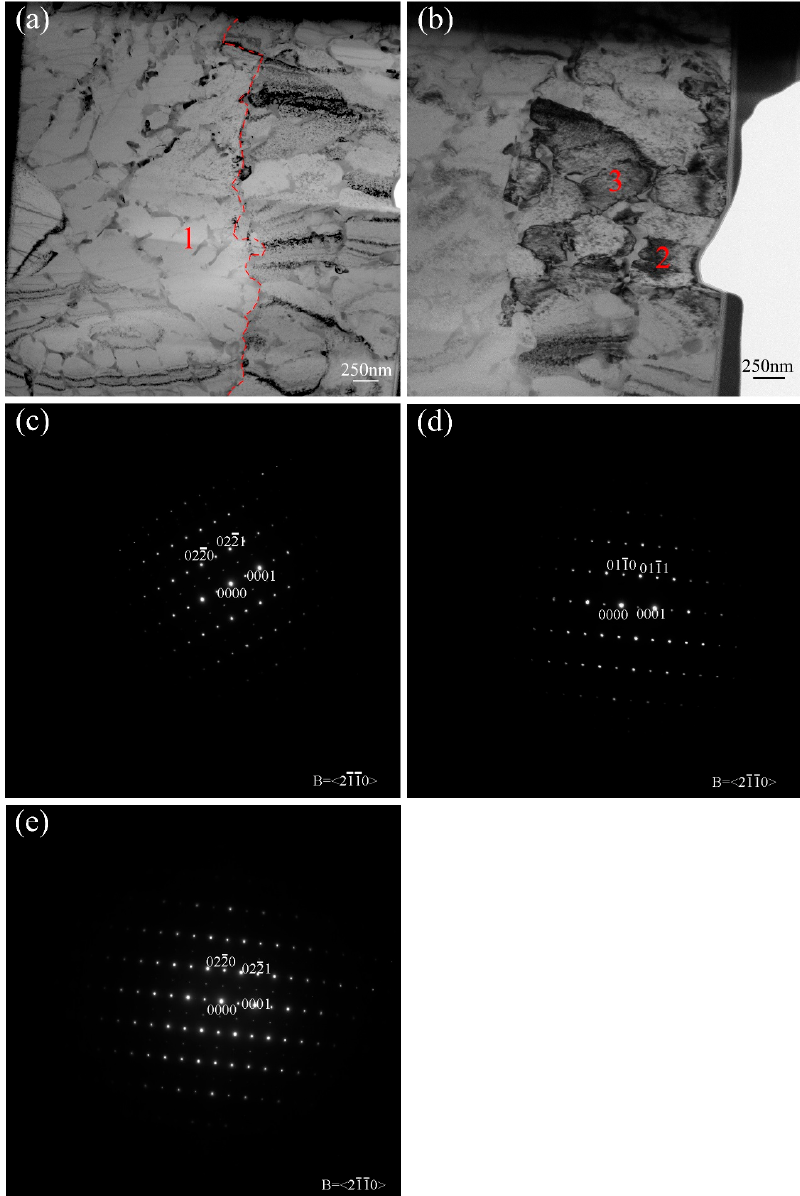
Figure 2. Cross-sectional TEM micrographs of the wires. Wheel contact surface is on the left of ( a , b ). ( a , b ) are the bright field images; ( c – e ) are the selected area diffraction patterns of regions in (a) and (b) marked by number 1, 2, and 3.